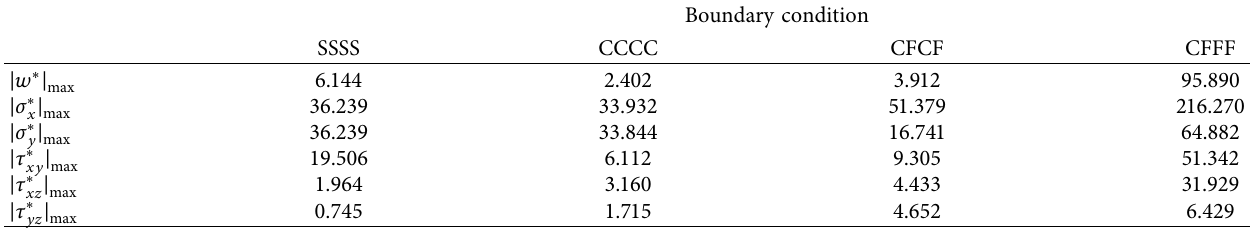
� 1, a / h � 10, a / b � 1, 0 , n